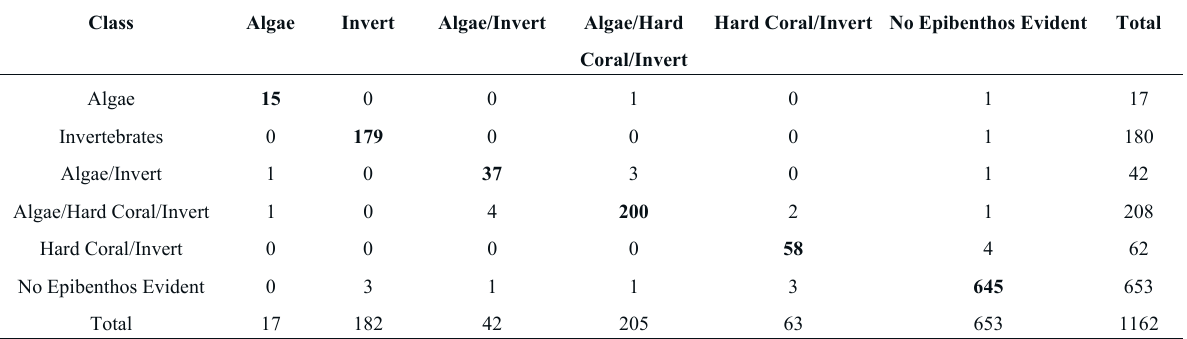
Table 5. Error matrix for the six habitat decision tree classification. Numbers in bold represent accurate incidences of